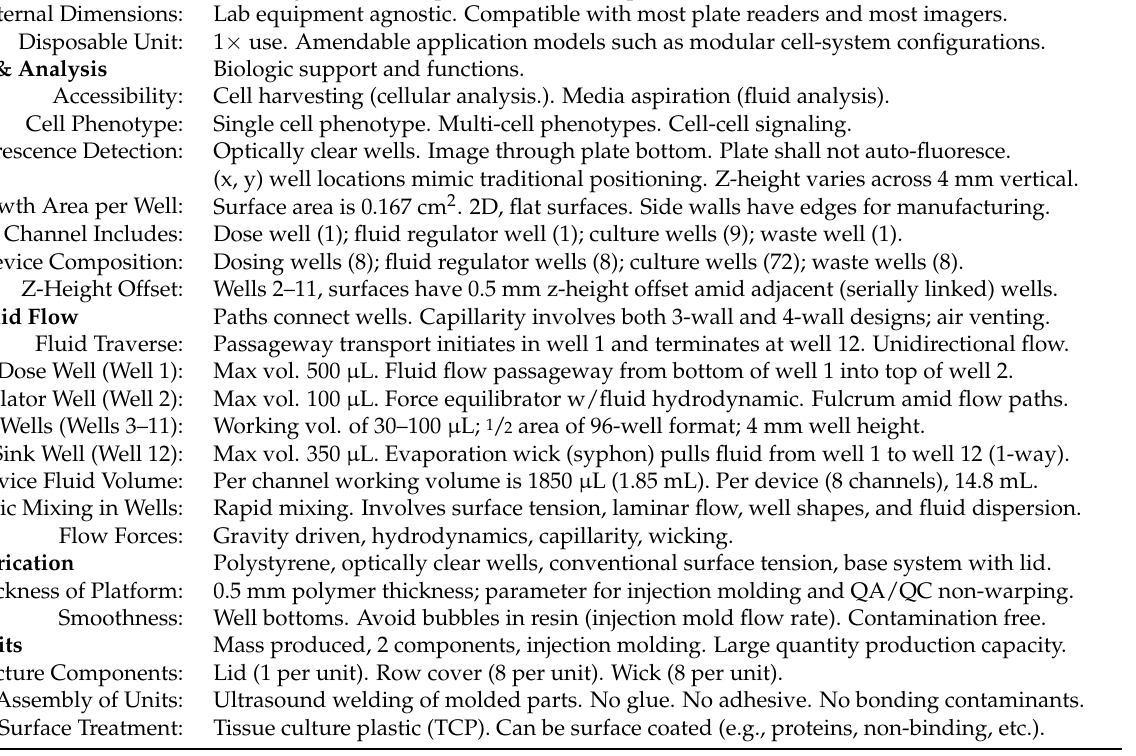
Table 1. µ Fluidics Culture Device—Attributes and